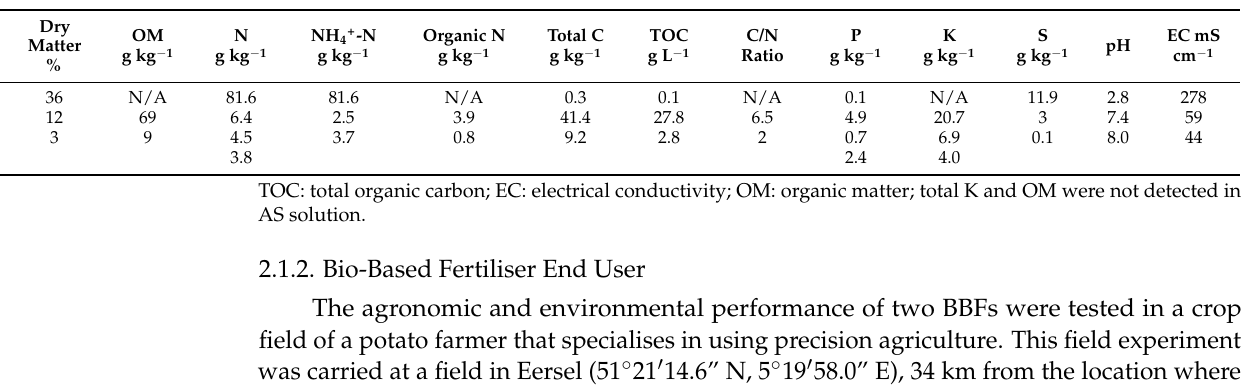
Table 1. The chemical composition of ammonium sulphate (AS), potassium concentrate (KC), liquid fraction of the digestate (LFD), and pig slurry manure